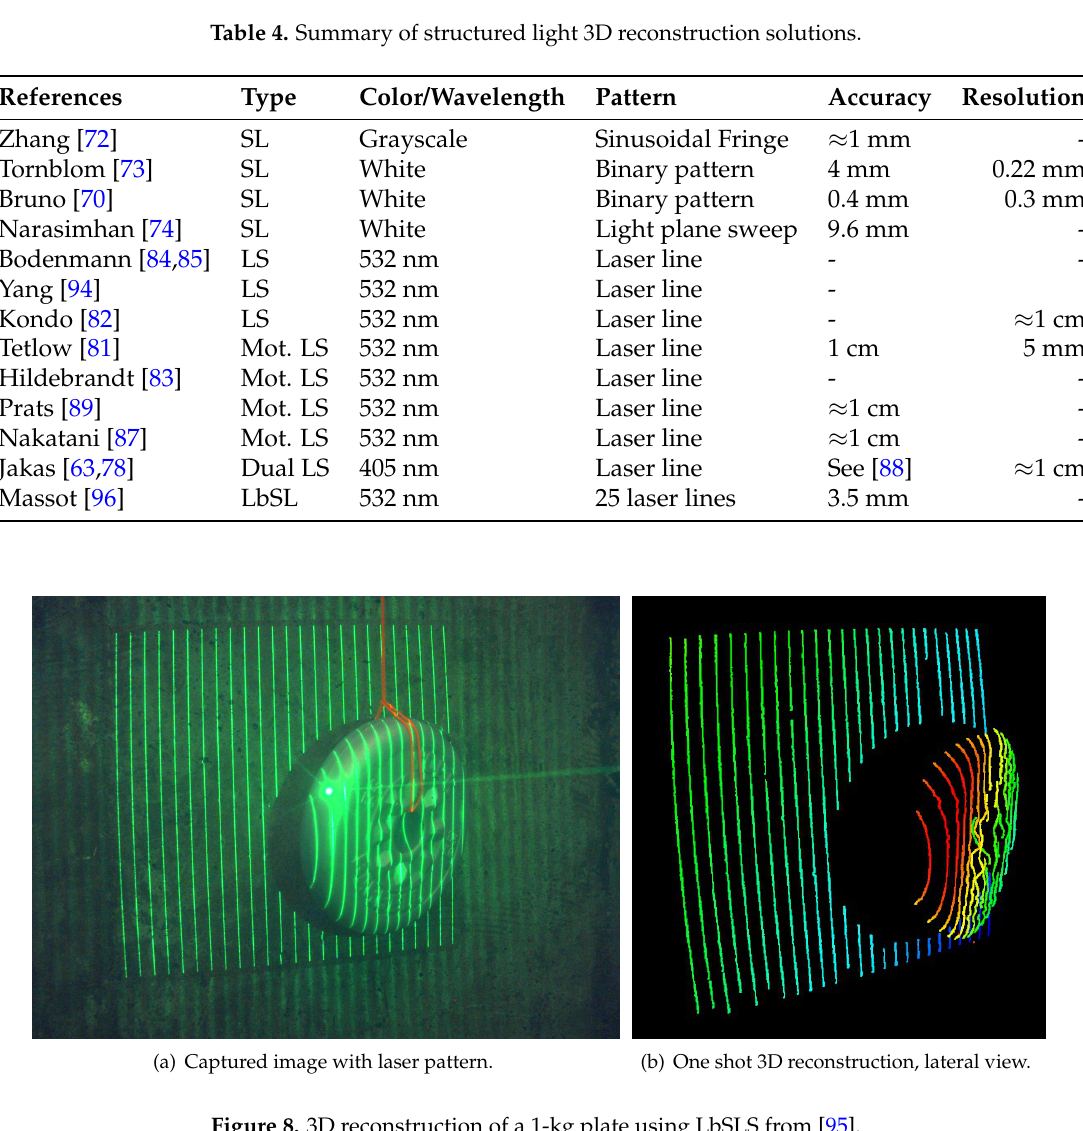
Figure 8. 3D reconstruction of a 1-kg plate using LbSLS from